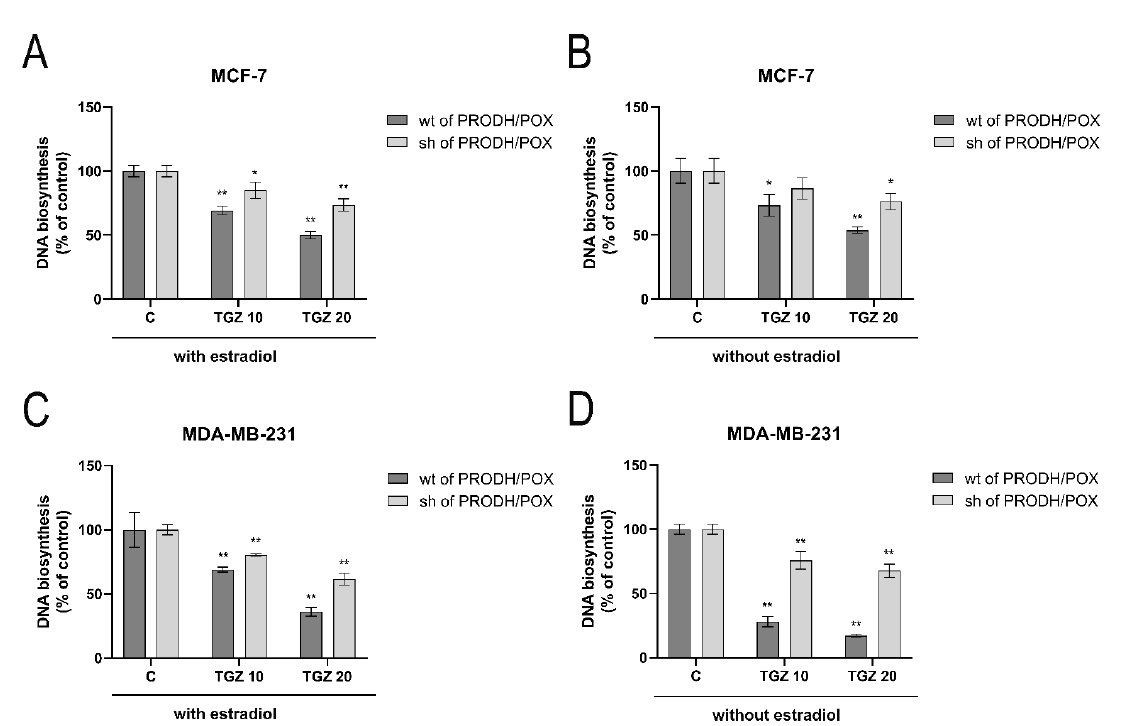
Figure 1. DNA biosynthesis in wild type (wt of PRODH/POX) and PRODH/POX-silenced (sh of PRODH/POX) MCF-7 and MDA-MB-231 cells treated for 24 h with troglitazone (TGZ) in the presence ( A , C ) and absence ( B , D ) of estradiol. The mean values ± standard deviation (SD) from 3 experiments done in duplicates are presented. Asterisks (*) indicate statistical differences between studied cells compared to controls at * p < 0.01 and ** p < 0.001.